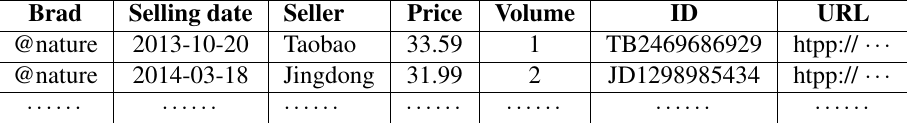
Table 6: Sales records: the scheme and the sample records